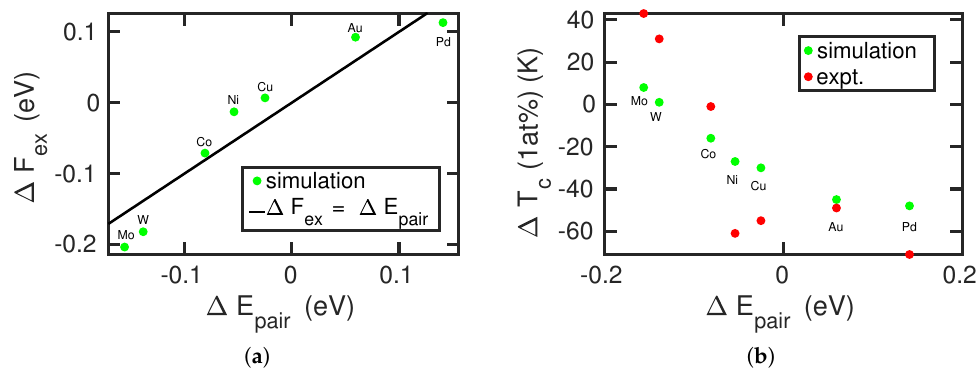
Figure 6. Correlation of ( a ) the energy difference between the fcc and bcc structures caused by the exchange of an Fe atom by an alloying atom, ∆ F ex , Equation (3), and ( b ) the change in α – γ transition temperature, ∆ T c , with the pair energy difference ∆ E pair , Equation (6). Experimental data in ( b ) are from [6,40]. The line in ( a ) shows the equality ∆ F ex = ∆ E pair .